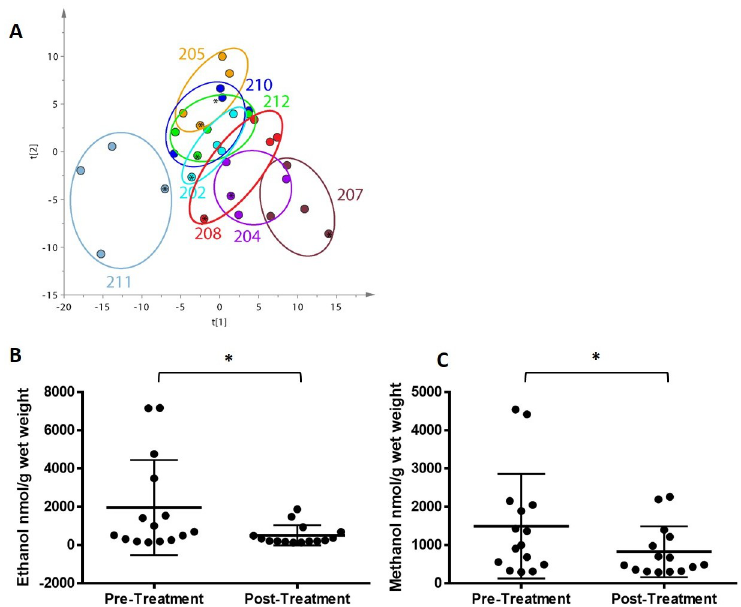
Fig 9. Changes in fecal, urinary and serum metabolomes with treatment. (A) Principal component analysis (PCA) plot of global fecal, urinary and plasma metabolomes changes by participant where numbers (e.g. 204, 212) represent participant IDs and the final metabolome (4th visit) is denoted by an asterisk, (B) mean ± SD fecal ethanol concentrations (n = 15 per group), (C) mean ± SD fecal methanol concentrations (n = 15). Significant differences in mean denoted by an asterisk (p <